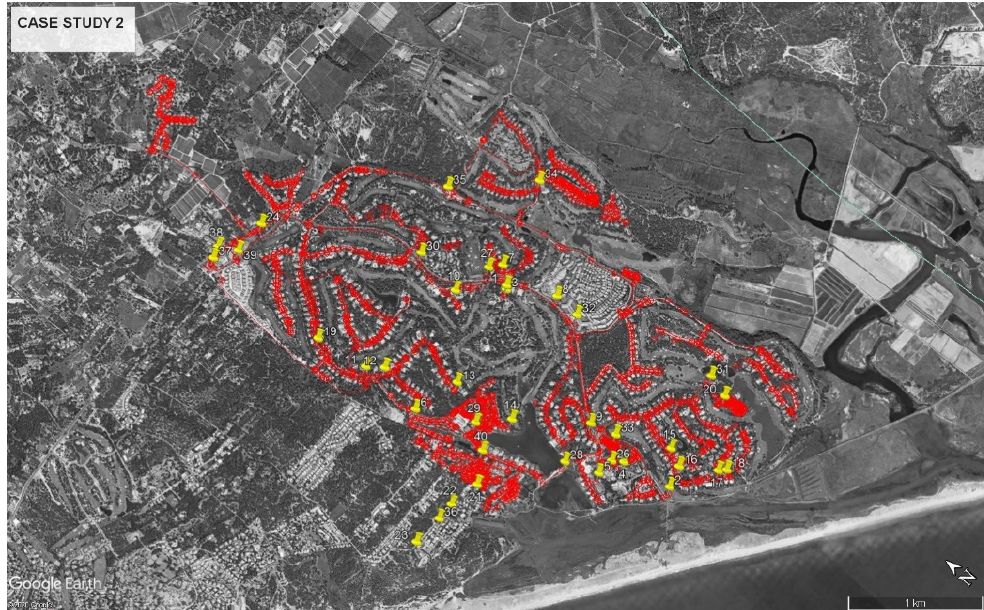
Figure 4. Case Study 2 water distribution system and water quality sampling locations.